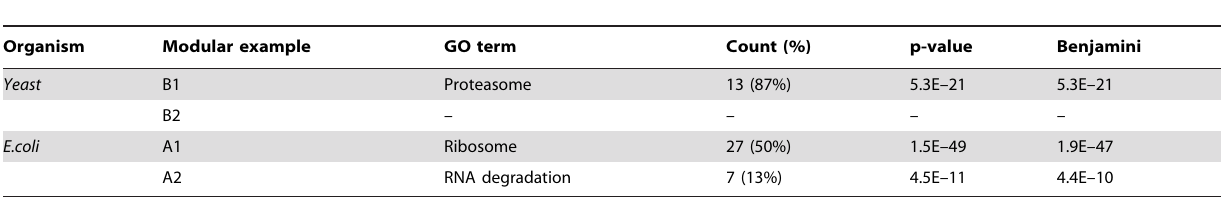
Table 1. Modular examples pathway enrichment analysis by DAVID.